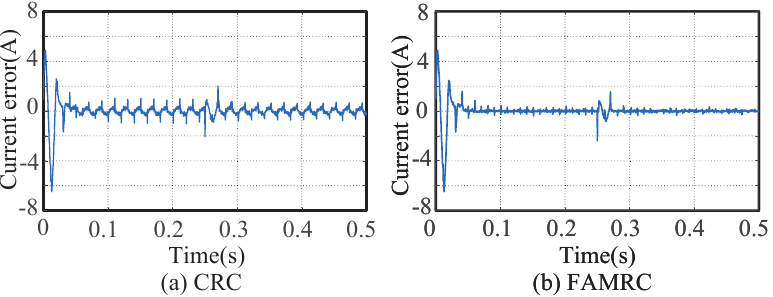
Figure 12. Current error of two control systems with grid frequency fluctuation ( f g = 49.6